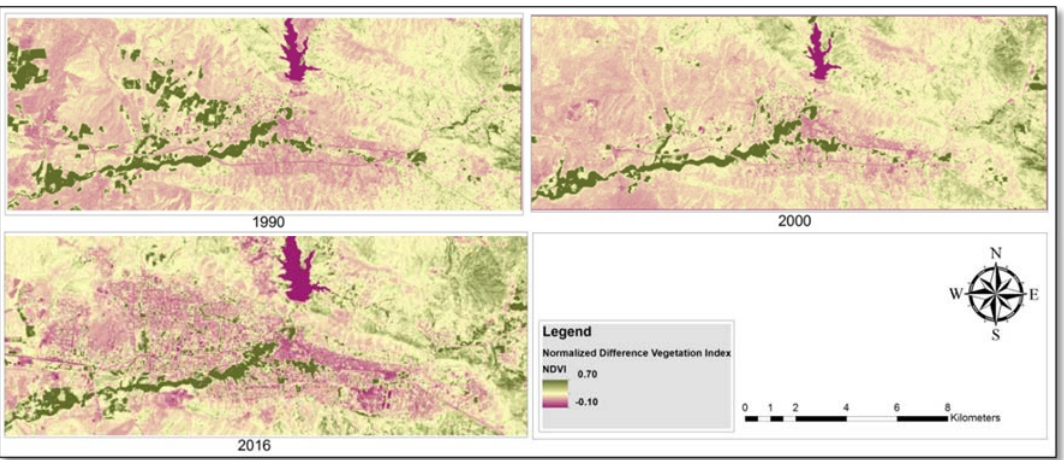
Figure 11. Normalized difference vegetation index (NDVI) in 1990, 2000 and 2016.